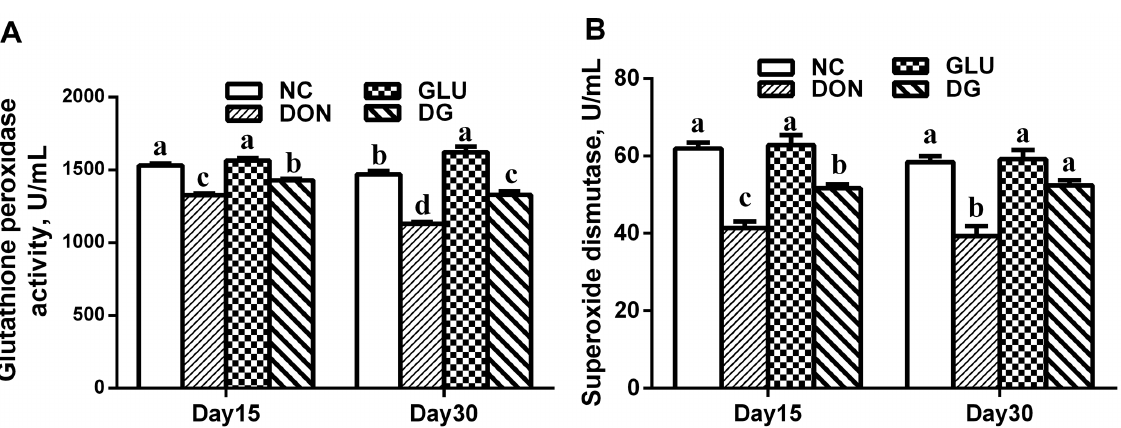
Fig. 1. Antioxidant enzymes activities in each group. A: SOD activity in each group at day 15 and 30. B: GSH-Px activity in each group at day 15 and 30. Dietary treatments were NC, an uncontaminated basal diet, DON, the basal contaminated with 4mg/kg deoxynivalenol, GLU, uncontaminated basal diet with 2% glutamic acid supplementation, and DG, deoxynivalenol-contaminated (4 mg/kg) basal diet with 2% glutamic acid supplementation. Data are presented as means ¡ SEM, n 5 5 for treatments, with a-d used to indicate statistically significant difference ( P , 0.05 , one way ANOVA method). SOD: superoxide dismutase (U/ml); GSH-PX: glutathione peroxidase (U/ml).